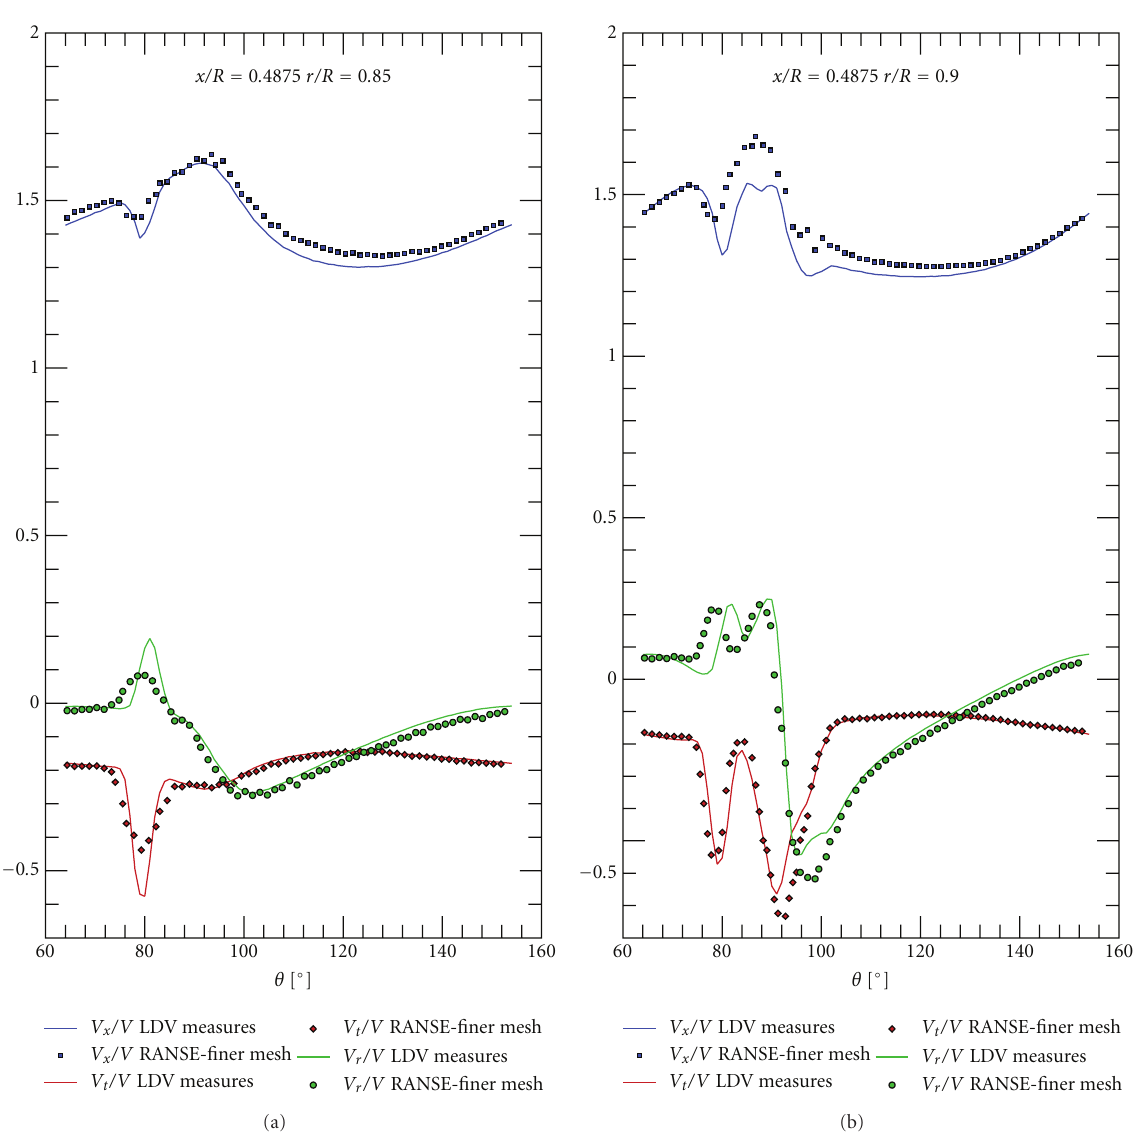
Figure 16: Axial, tangential, and radial vorticity distributions at x/R = 0.4875, r/R = 0.85, and r/R = 0.90. Comparison between LDV and RANSE (single blade angular